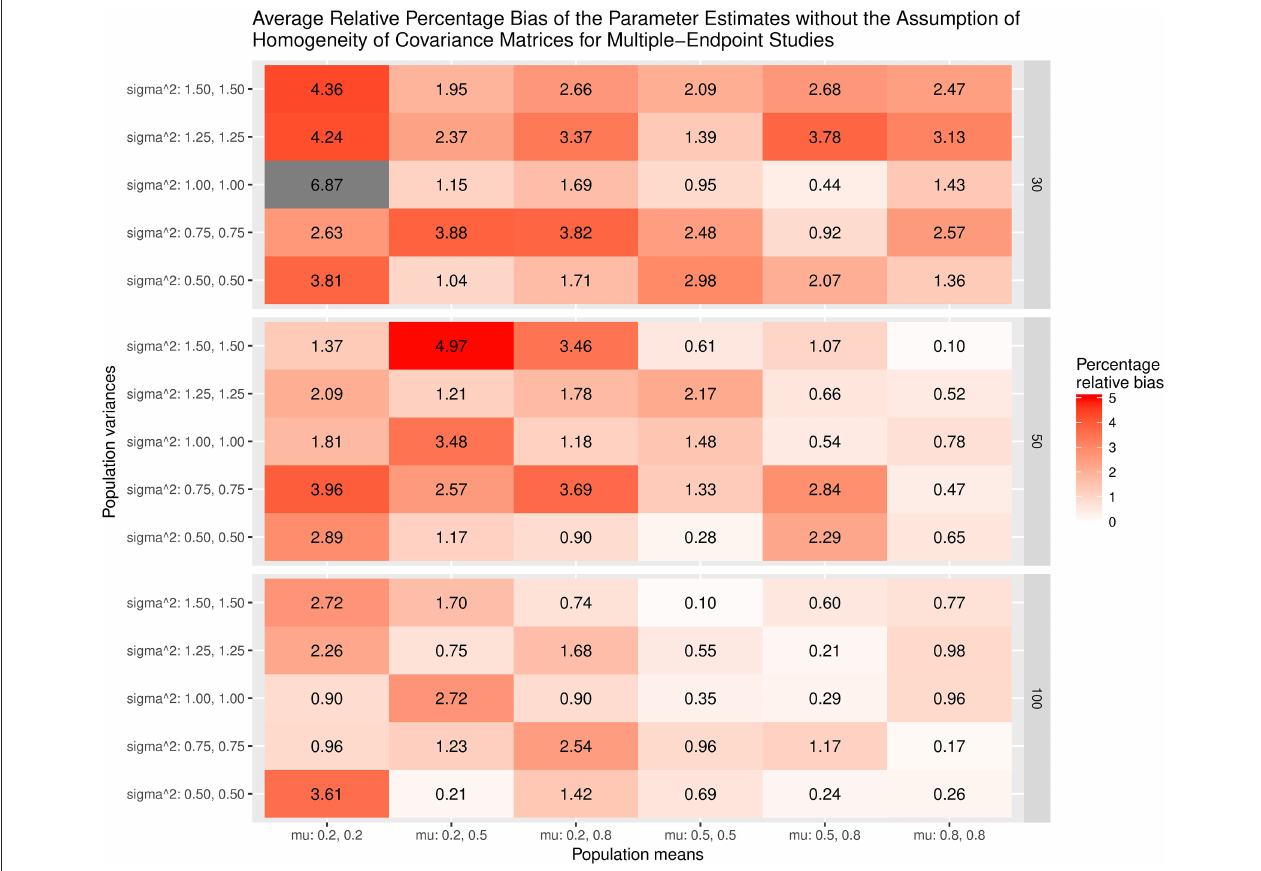
FIGURE 8 | Relative bias of the average of parameter estimates for the multiple-endpoint studies without the assumption of homogeneity of covariance matrices.